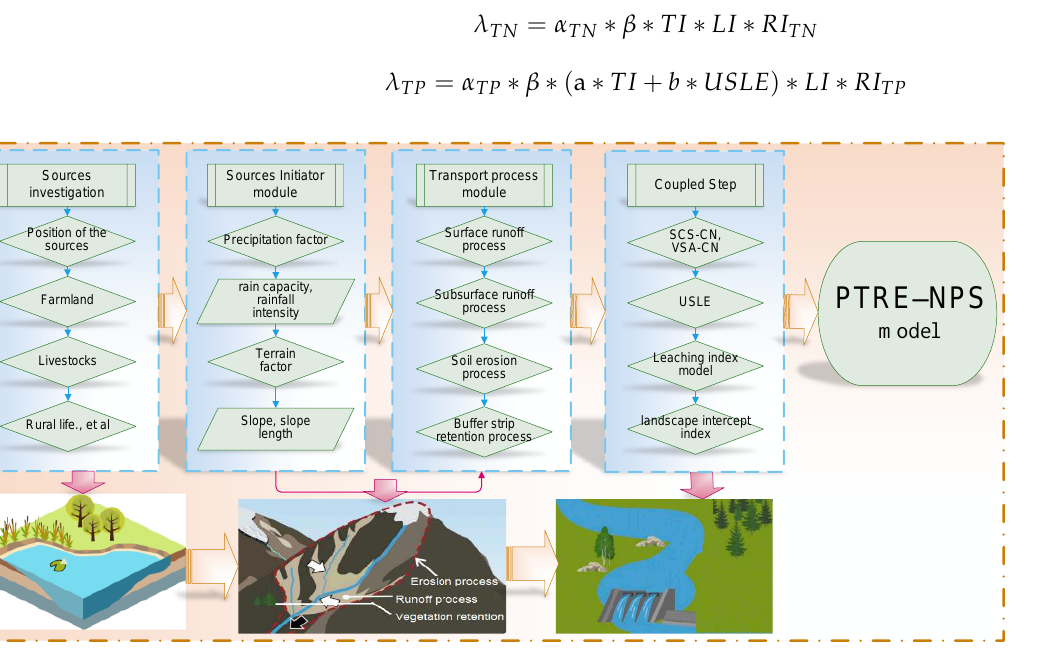
Figure 2. The framework of the PTRE-NPS model.